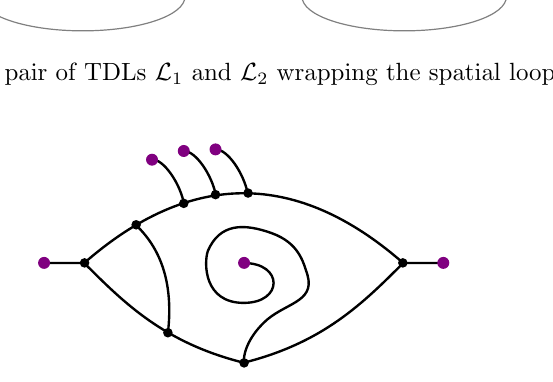
Figure 2 . An admissible con(cid:12)guration of TDLs with endpoints (purple dots), joined by T-junctions (black